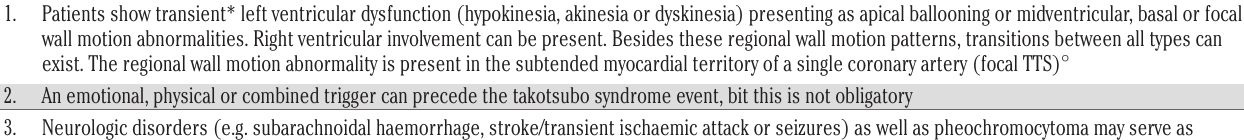
Table 2. International Takotsubo Diagnostic Criteria (InterTAK Diagnostic Criteria). 19